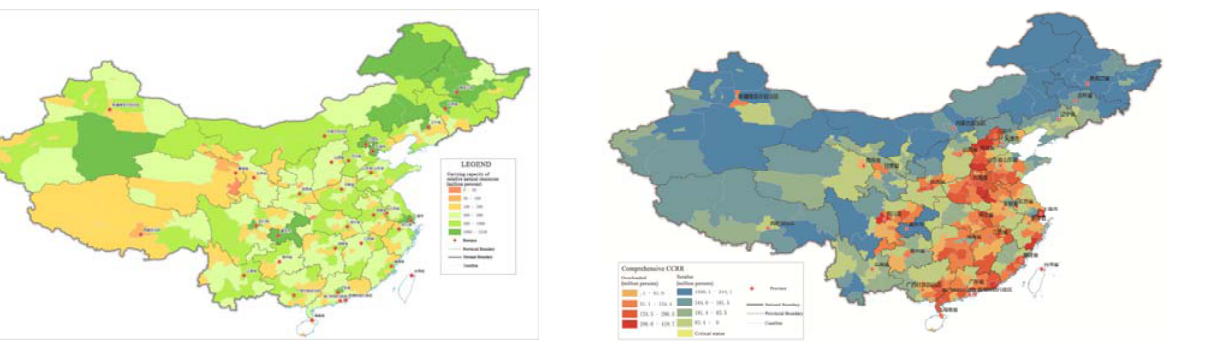
Figure 5. Comprehensive CCRR in